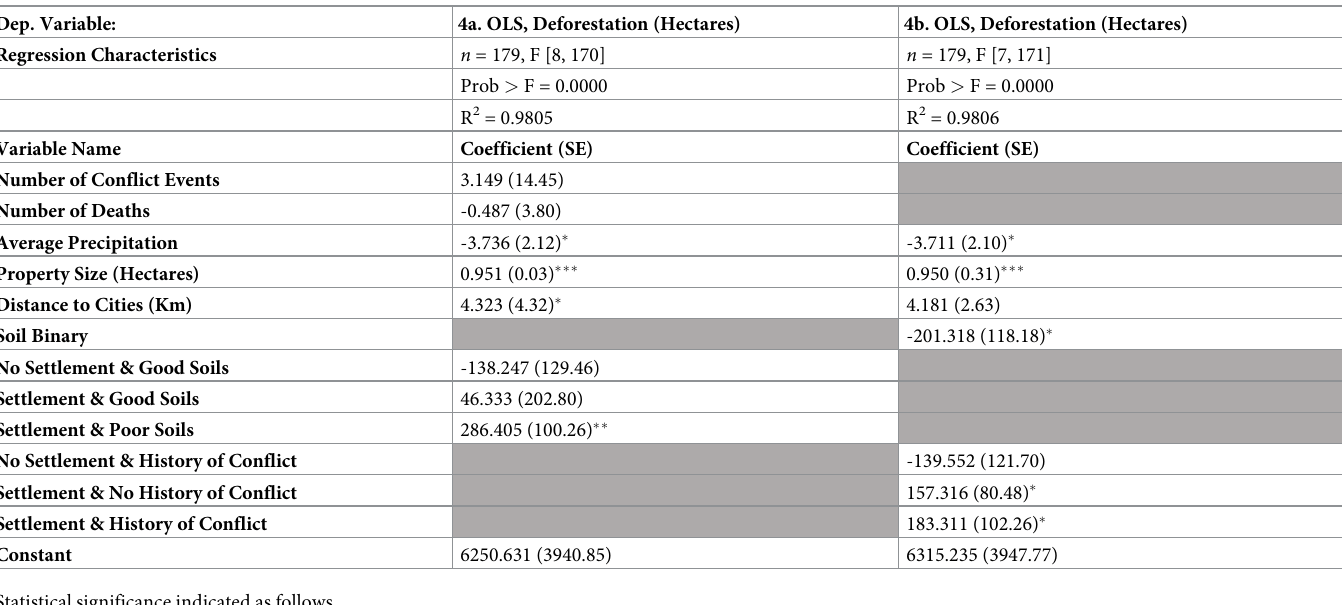
Table 3. H3 regression